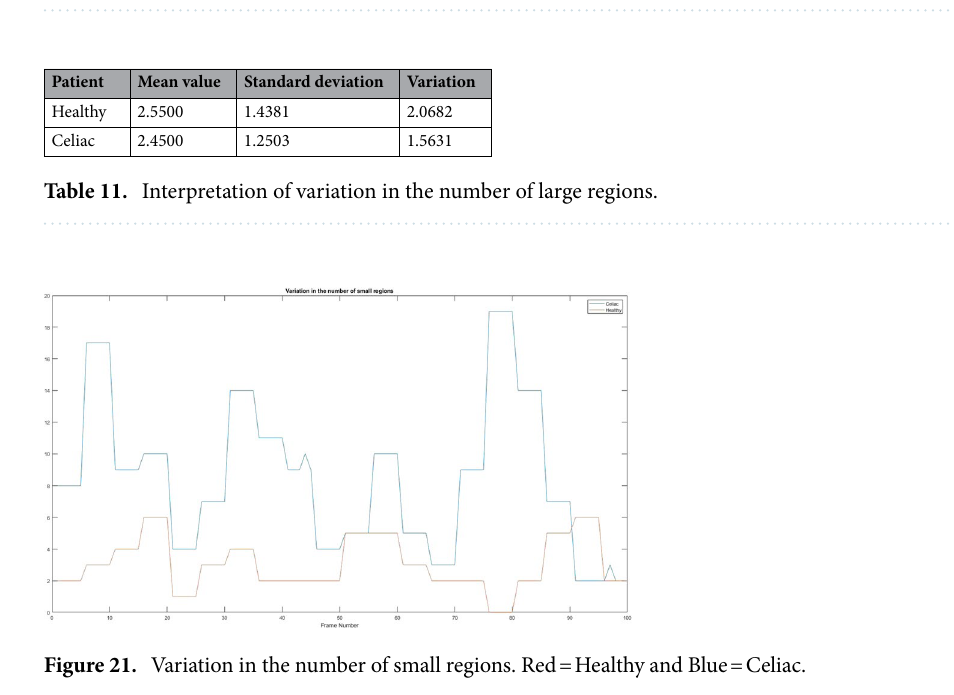
Figure 20. Variation in the number of large regions. Red = Healthy and Blue = Celiac.